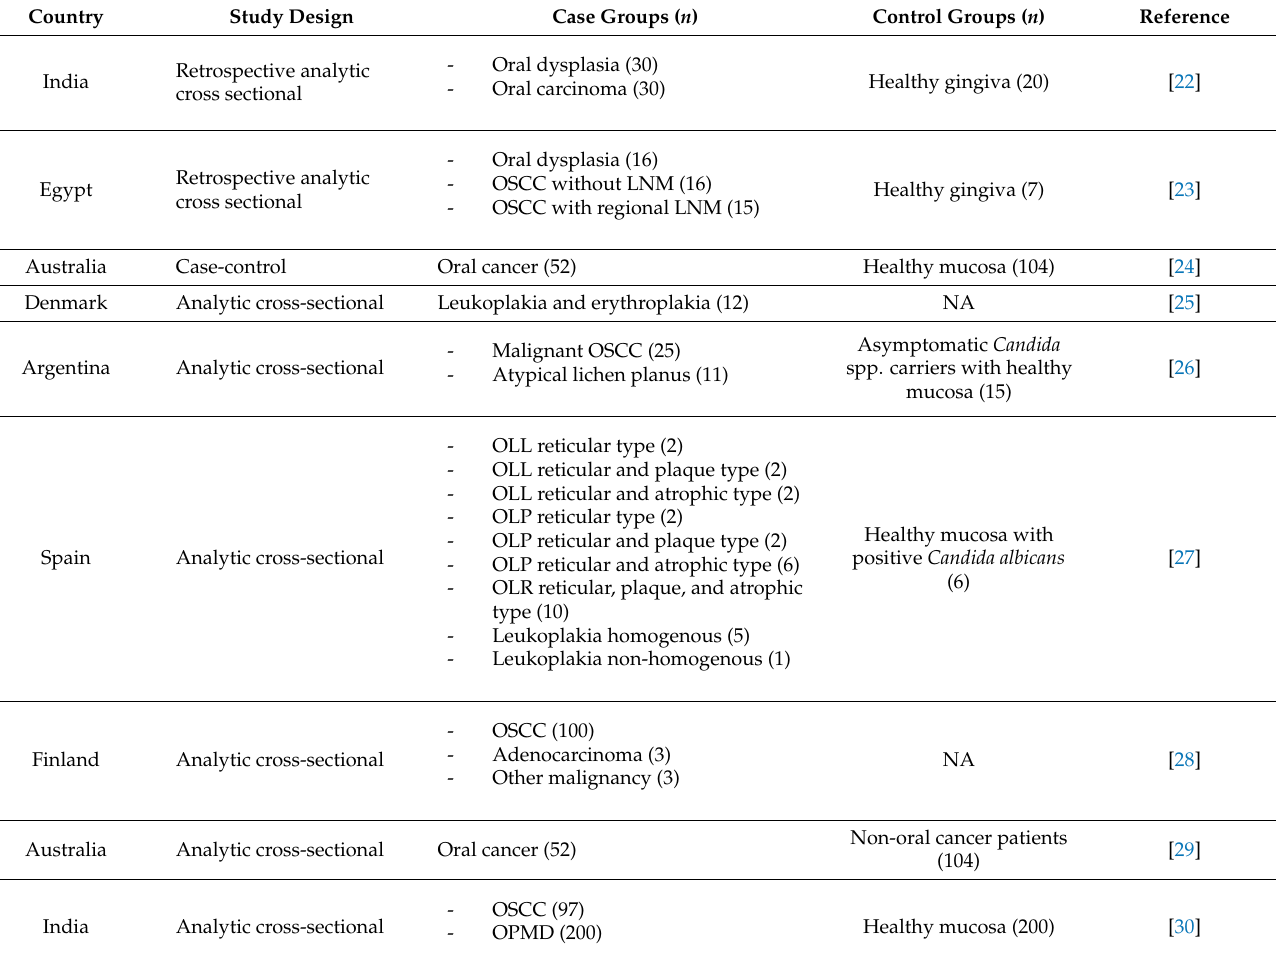
Table 1. Sample characteristics in each